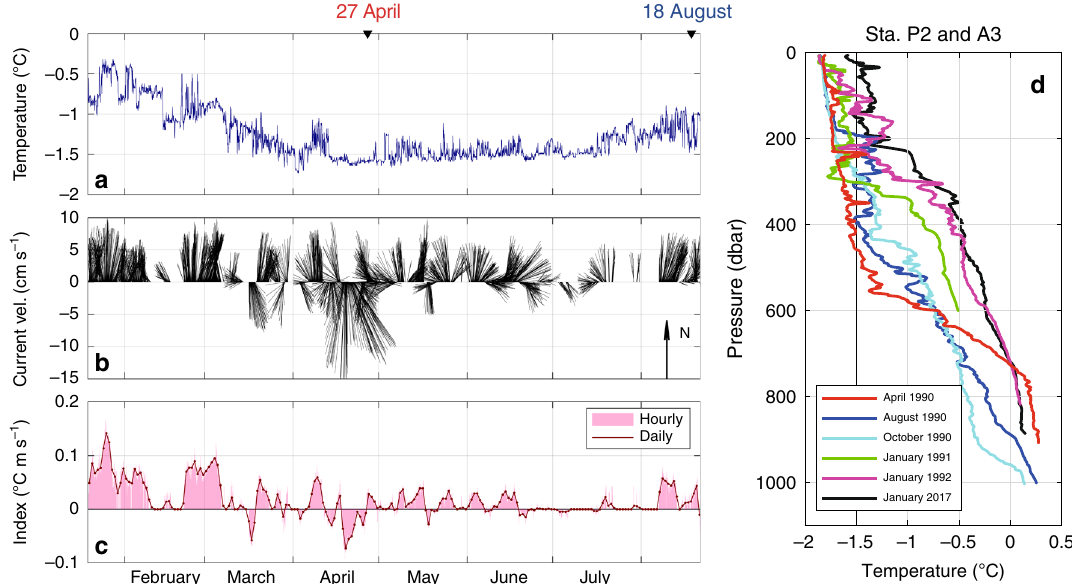
Fig. 6 Past hydrographic data from 1990 to 1992. Time series of ( a ) temperature, ( b ) current velocity, and ( c ) basal melt fl ux index (bar: hourly mean, line with dots: daily mean) at nominal depth of 300 dbar at Sta.P2 (almost the same position as Sta.A3, yellow star in Fig. 1a) from late January to August in 1990. Two inverted triangles on the upper axis of panel a denote the date of CTD observations at Sta.P2 (red: April 1990 and blue: August 1990) shown in d . d Vertical pro fi les of temperature obtained in April, August, and October 1990, January 1991, January 1992 at Sta.P2 (JARE 31st and JARE 32nd, color), and January 2017 at Sta.A3 (JARE 58th, black). For emphasis, T = − 1.5 o C, de fi ned as the lower boundary of Winter Water layer 19 , is denoted by vertical thick